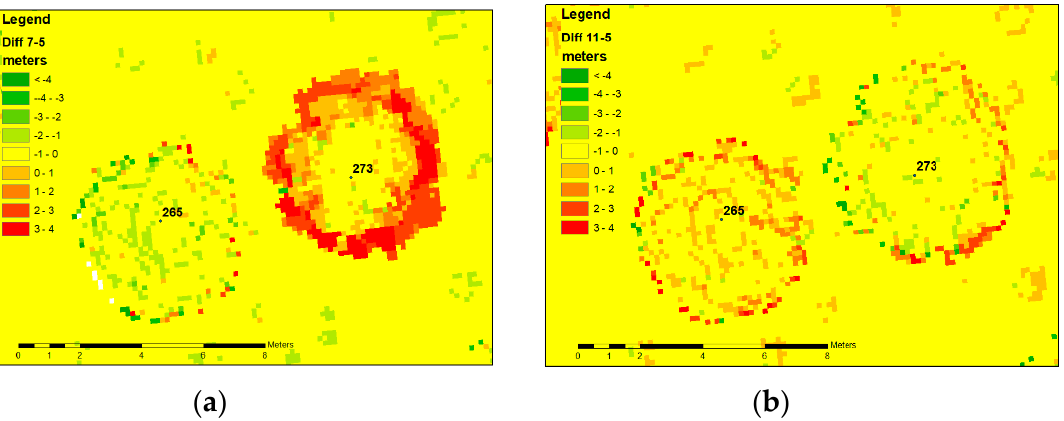
Figure 4. Comparison of two selected tree heights (maximum height value in raster cell from 3D point cloud) displaying raster of 10 cm·pixel differences of two flights where tree 265 was not detected to have bending branches and tree 273 was detected to have bending branches: ( a ) Difference between summer and spring flight; raster values around tree 273 are red cells with positive values showing the difference in crown structure (e.g., bent branches); ( b ) Difference between spring and autumn flights; cell values around tree 273 show no difference, as the branches have returned to their spring positions.